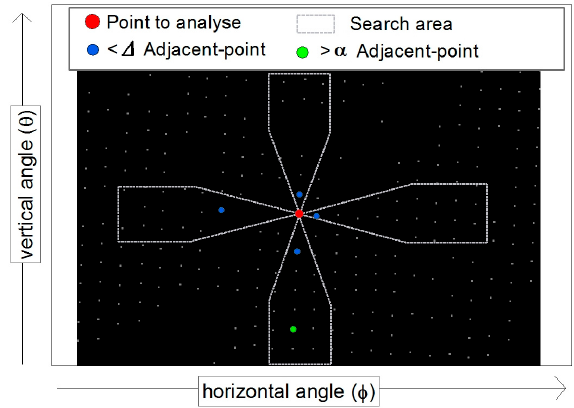
Figure 2. Horizontal-vertical (HOVE) grid and search area for horizontal and vertical angles.